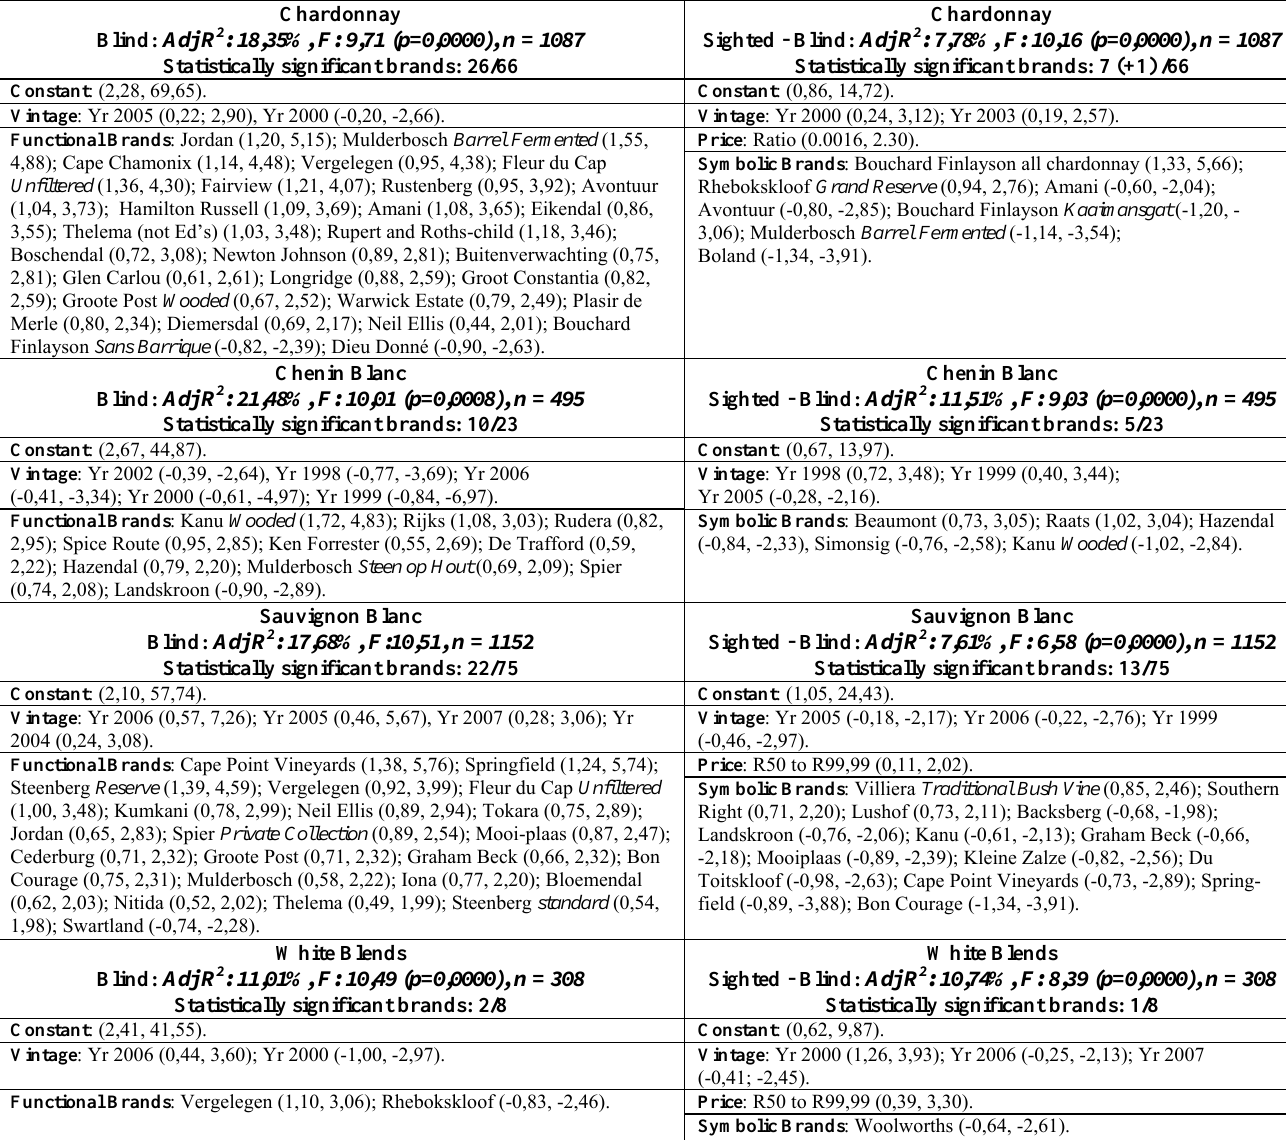
Table 10: Estimated white varietal regressions explaining blind and sighted minus blind wine assessments with controls for vintage and price. Where statistically significant at the 5% level, model variables appear, with their respective coefficients and t-statistics in parenthesis in the sequence: constant, vintage, price (for symbolic effects), and brand. Each variable is sorted by order of t -stat. (Note that with price effects an additional chardonnay symbolic brand is identified.)